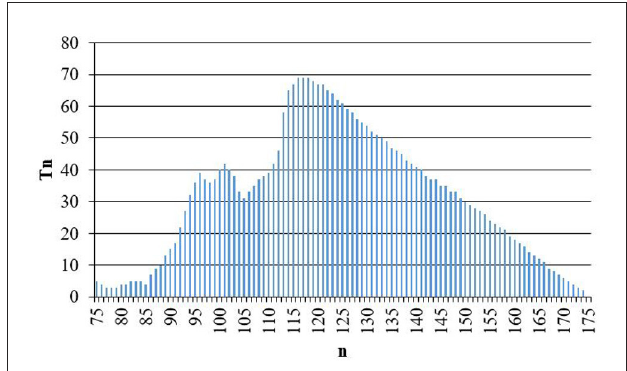
FIGURE13 Prediction length of the second